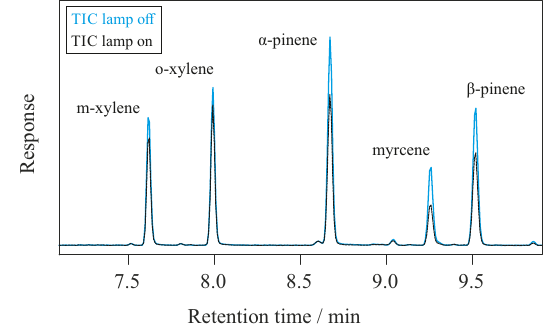
Figure 2. Typical total ion chromatograms (TICs) obtained for a ppbv mixing ratio gas standard (Mixture 1) with the lamp off (blue) and lamp on (black). Greater differences in peak areas are ob- served for VOCs which react faster with OH. Literature rate co- efficients (in units of 10 − 12 cm 3 molecule − 1 s − 1 ) for the VOCs are m -xylene 1 , 23 ( ± 4); o -xylene 1 , (13 ± 3); α -pinene 2 , myrcene 1 , 209 ± (42); and β -pinene 1 , 79 ± (20). 1 Atkinson and Arey (2003) updated to reflect changes in reference compound. 2 Atkinson et al. (2006) –